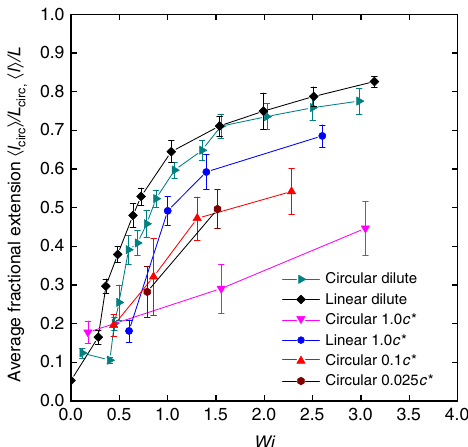
Fig. 7 Steady and average unsteady fractional extension of linear and ring polymers in extensional fl ow. Experimental data for ring polymers in semidilute unentangled linear solutions at 0.025 c * , 0.1 c * , and 1.0 c * are shown in dark red hexagon, red up triangle, and magenta down triangle, respectively. Experimental data for dilute ring polymers (dark cyan right triangle) are taken from Li et al. 36 , and data for 1.0 c * linear polymers (blue circle) are taken from Hsiao et al. 33 . Molecular ensembles consist of at least n ≥ 35 molecules at each concentration and error bars represent standard deviation. Source data are provided as a Source Data fi